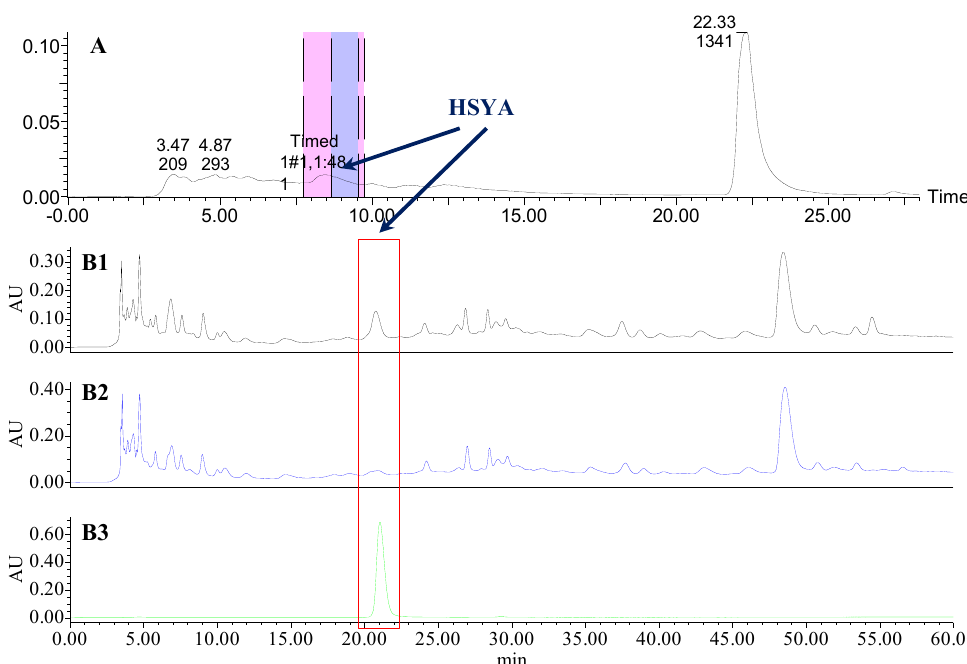
Figure 5. The preparative and analytical chromatograms of the depletion of HSYA from CF-SM. ( A ) preparative chromatogram at 270 nm; ( B1 ) analytical chromatogram of CF-SM at 270 nm; ( B2 ) analytical chromatogram of CF-SM-A at 270 nm; ( B3 ) analytical chromatogram of HSYA depleted from CF-SM at 270 nm.